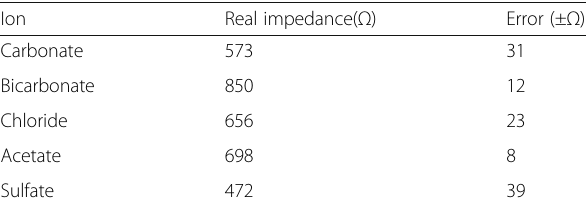
Table 4 Real impedance values ( Ω ) of 0.6 ppm solutions of anions at 25.0